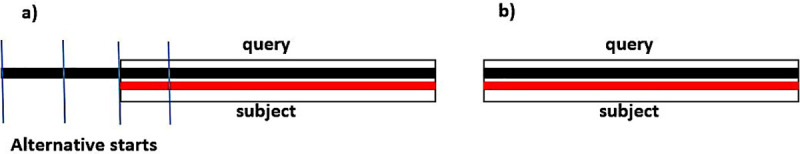
Identification of codons.Identification process of possible start codons in the genomic sequence and comparison to the information in the database; (a) alternative start sites and (b) result after adjustments.